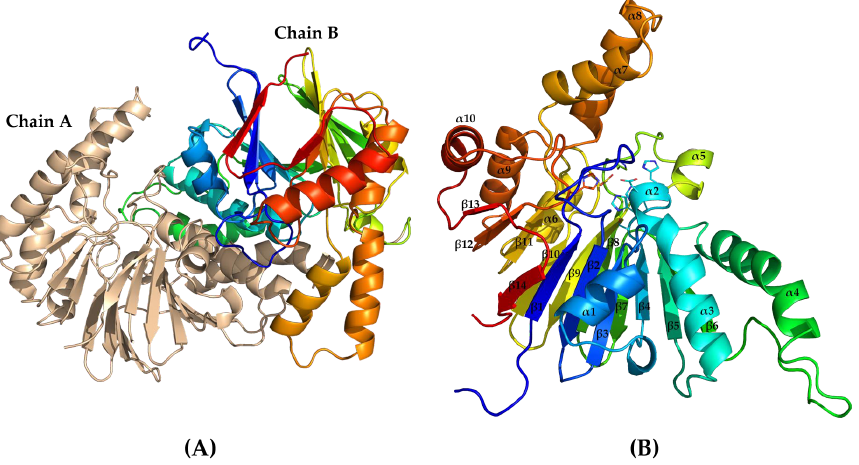
Figure 5. Cartoon representation of PaAst. ( A ) Dimer of PaAst. Chain A is colored in wheat and Chain B in rainbow color. ( B ) PaAst monomer. Side chains of the conserved Zn 2+ -binding motifs are shown with lines.